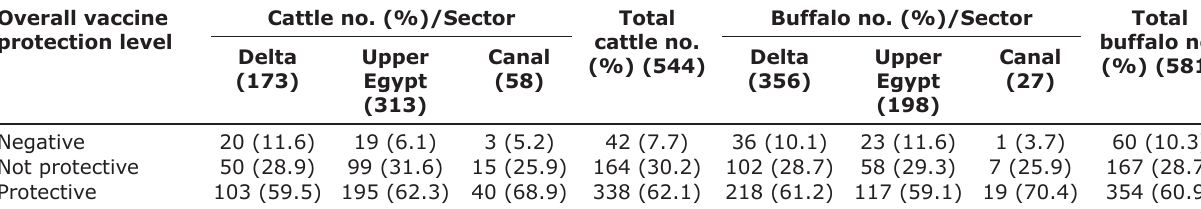
Table-2: Overall protection level of FMD vaccine (post-vaccination serosurveillance) in negative NSPs serum samples in cattle and buffaloes using SPCE. Overall vaccine Cattle no. (%)/Sector Total protection level cattle no.